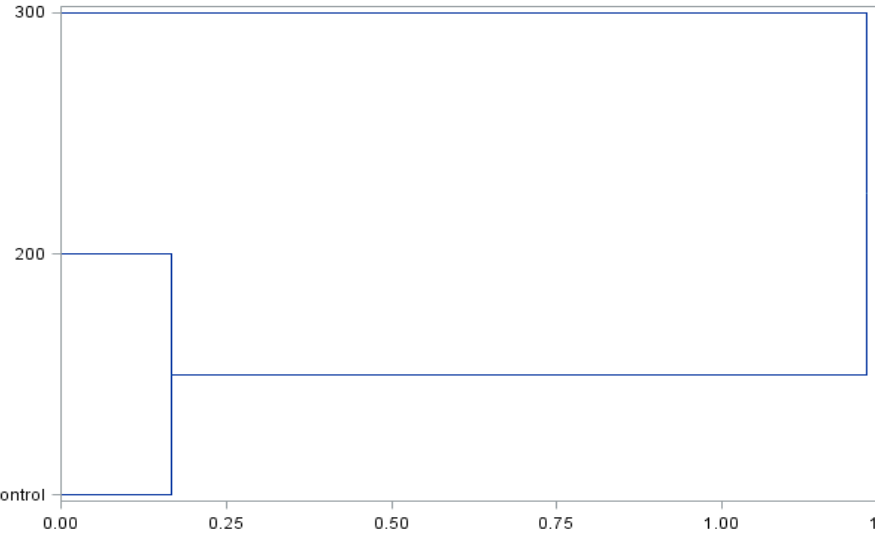
Figure 8. Branching-tree diagram for the hormonal treatment and the concentration of gibberellic acid applied in ‘Einset Seedless’ fruits.